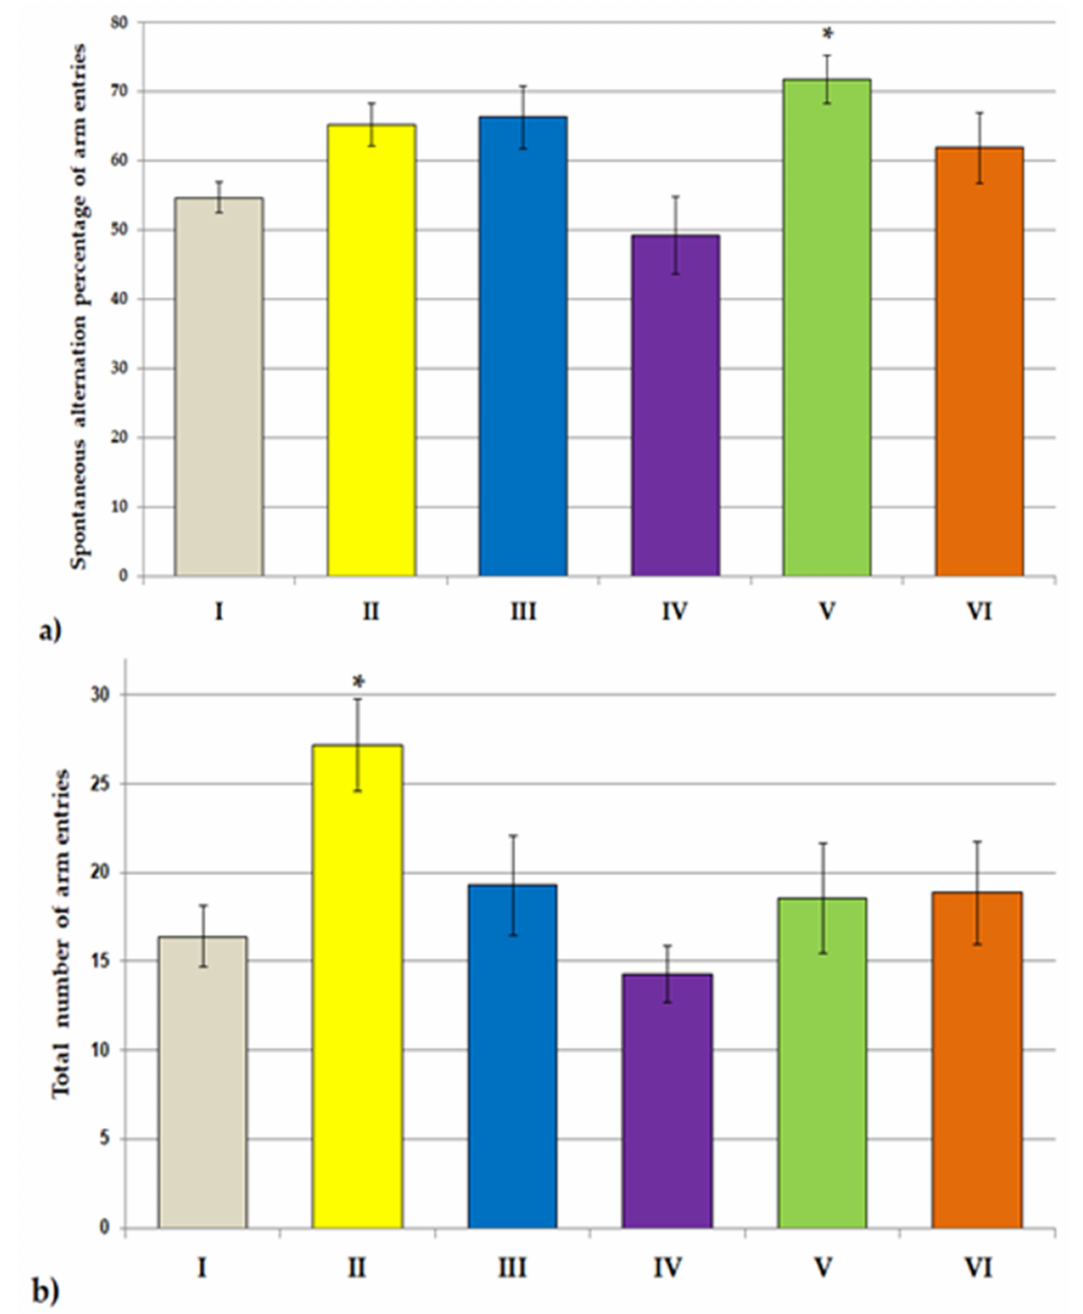
Figure 2. The influence of extracts on the spontaneous alternation behavior and spatial mem- ory in Y-maze test. The percentage of spontaneous transformation ( a ) and the total number of entries into the arm ( b ) were determined. All values are reported as mean ± SEM ( n = 7). Significance: * p < 0.05, vs. control group (one-way ANOVA followed by Tukey’s post hoc